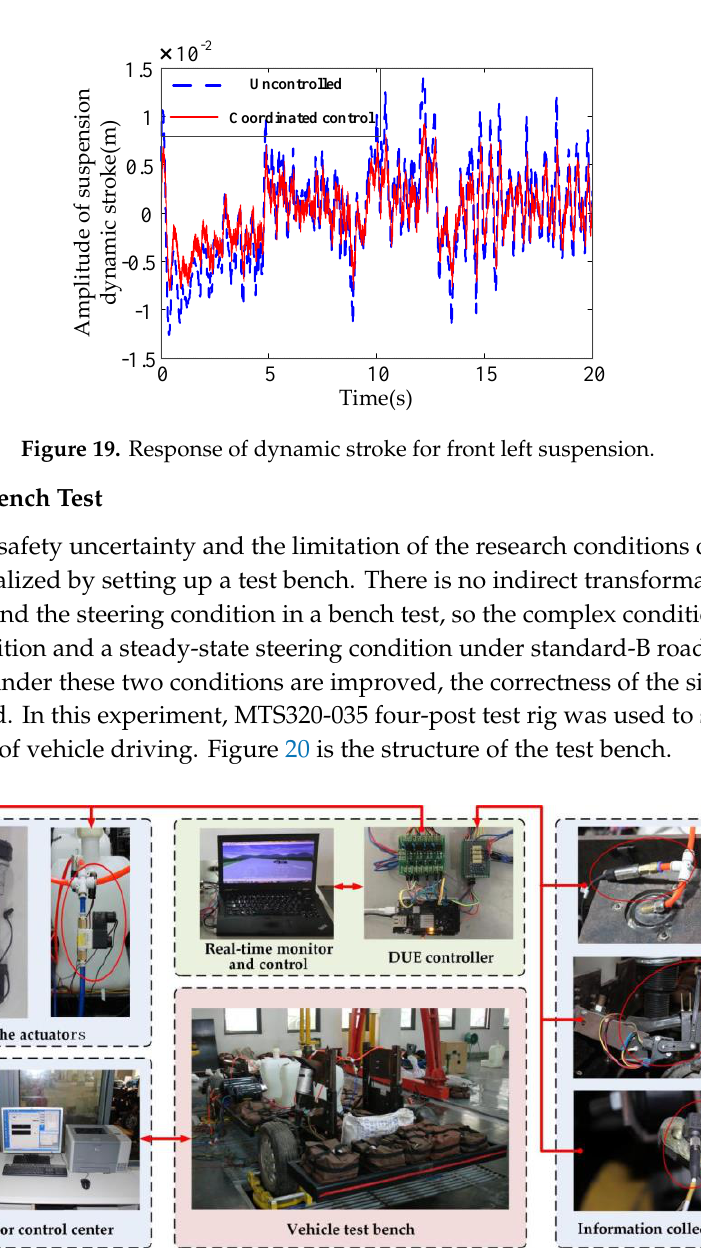
Figure 18. Response of vehicle pitch angle.